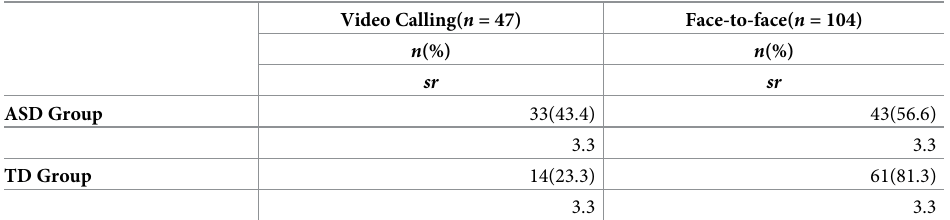
Table 3. Results of the chi-square test of independence and residual analysis.